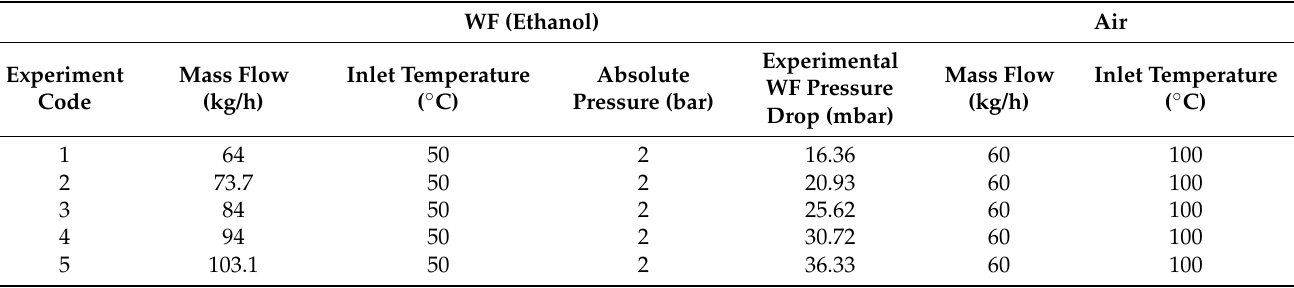
Table 1. Set of experiments of monophasic flow.